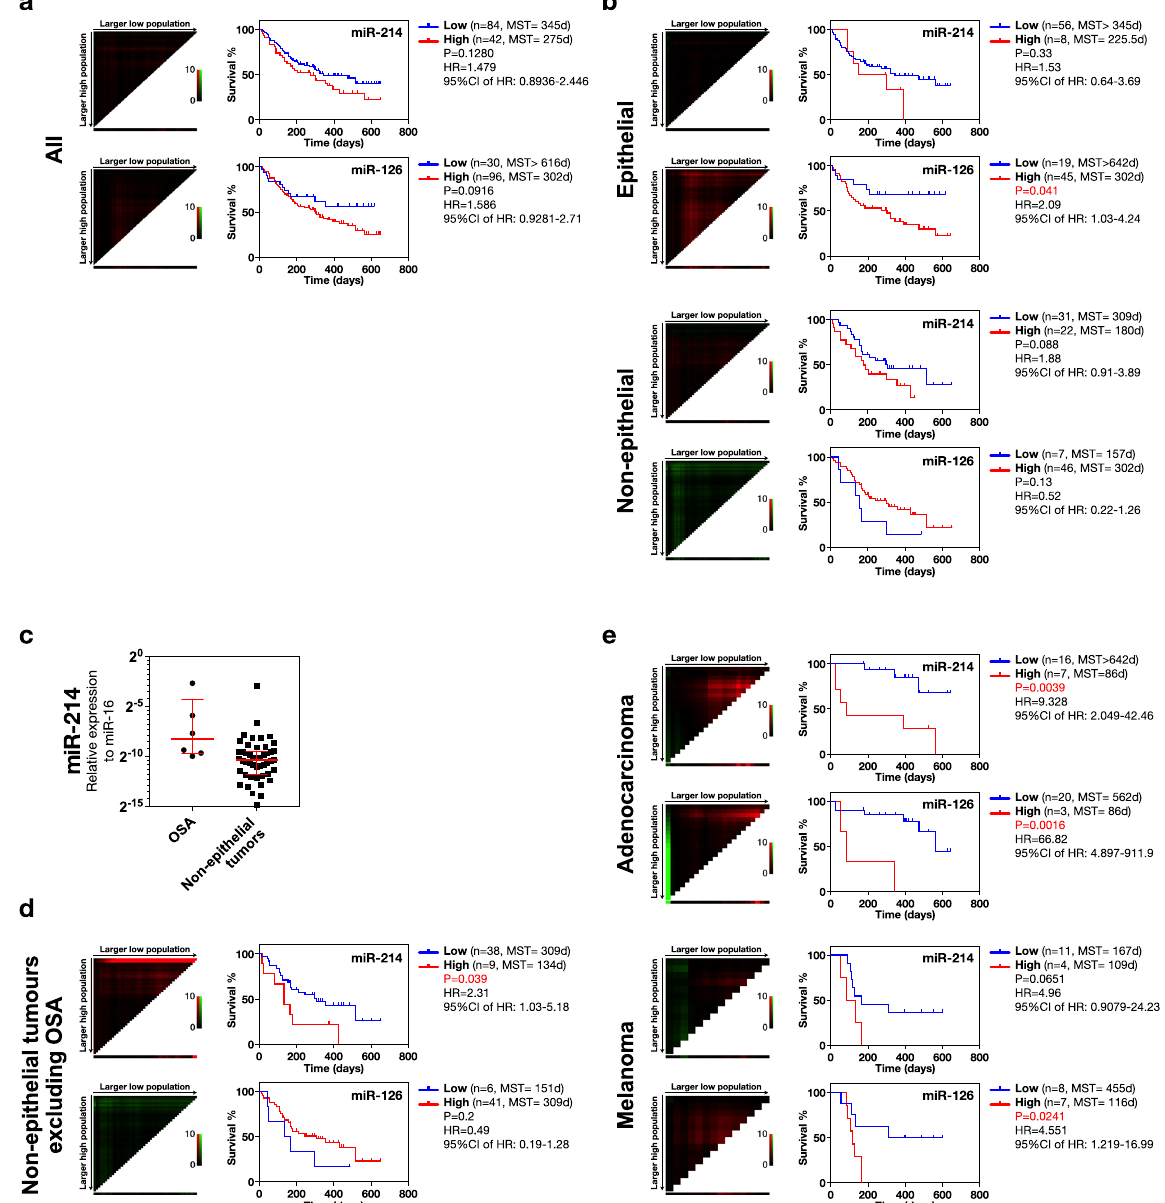
Figure 6. Survival analysis using Kaplan-Meier survival curve and X-tile plot. The cases with high levels of circulating miR-214 showed significantly shorter survival time in the cases of adenocarcinoma and the non- epithelial tumours without osteosarcoma. The cases with high levels of circulating miR-126 showed significantly shorter survival times in the cases of epithelial tumours, adenocarcinoma, and melanoma. (a) Survival times between the cases with high- and low-circulating miR-214 and -126 in the group including all types of tumours. (b) Survival times between the cases with high- and low-circulating miR-214 and -126 levels for the epithelial and the non-epithelial tumours. (c) Comparison of the levels of circulating miR-214 between osteosarcomas (OSA) and the other non-epithelial tumours. (d) Survival times between the cases with high- and low- circulating miR-214 and -126 levels for the non-epithelial tumours excluding osteosarcomas. (e) Survival times between the cases with high- and low-circulating miR-214 and -126 levels for adenocarcinomas and melanomas. All MST values (days) were calculated from the analysis using Kaplan-Meier survival curves. The optimal cut-offs to determine the groups of high- and low-miRNA levels were calculated by use of the X-tile plot. The hazard ratios and P-values were calculated by using the Log-rank